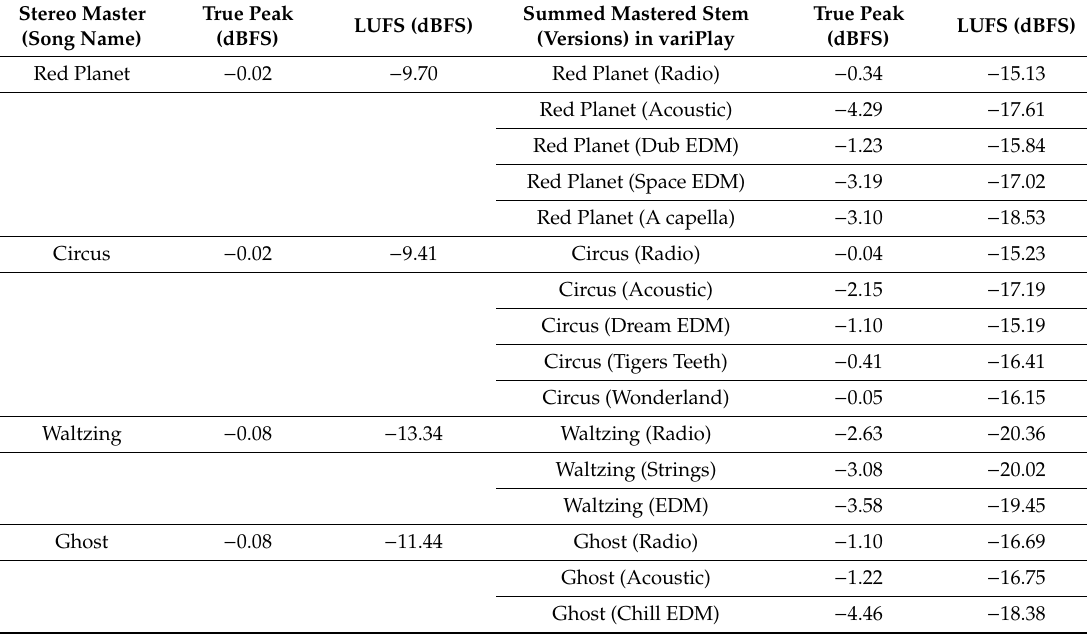
Table 2. Comparison of peak and loudness measures for songs and versions incorporated in Red Planet EP by Daisy and The